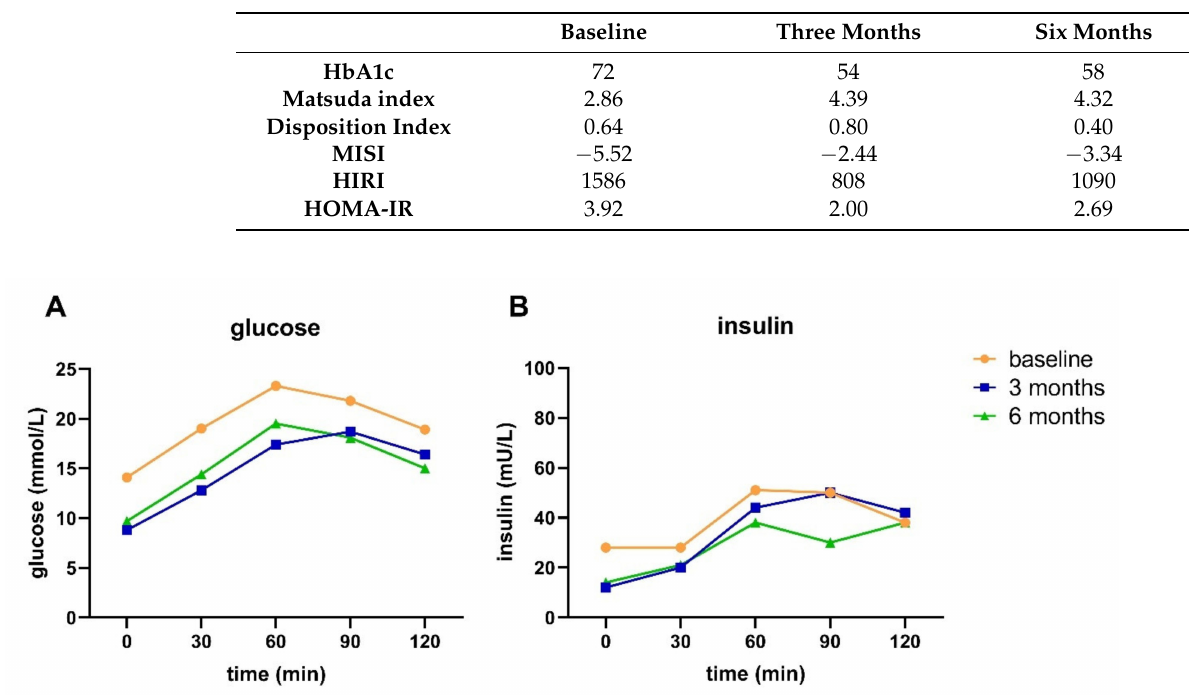
Table 7. HbA1c and T2D indices derived from an OGTT for participant C at baseline and after three months and six months of intervention.